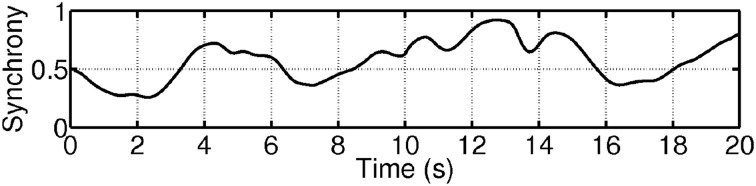
Example of an overall synchrony measure while a participant was watching a neutral picture and a disgust eliciting picture for 10 s each.